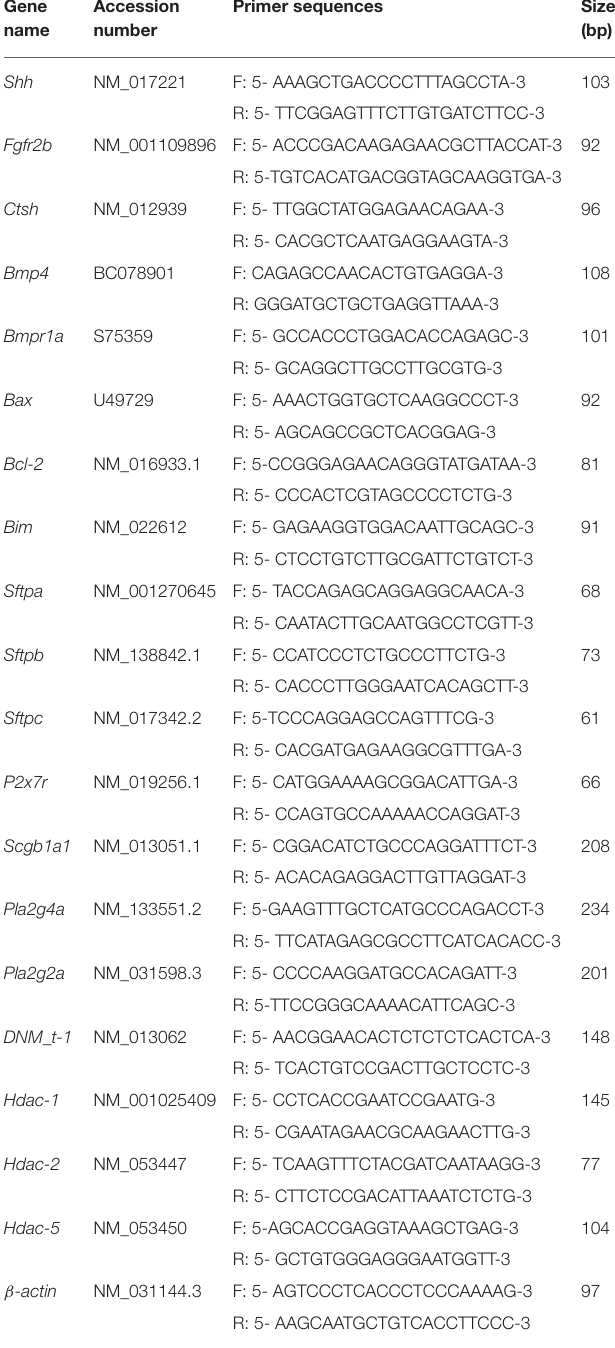
TABLE 1 | Primers used in quantitative real-time